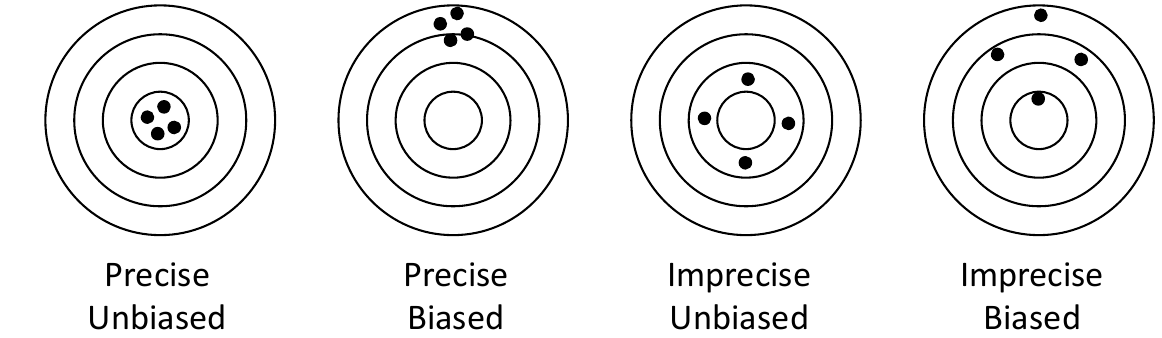
Figure 1. Precision and bias in relation to the criterion